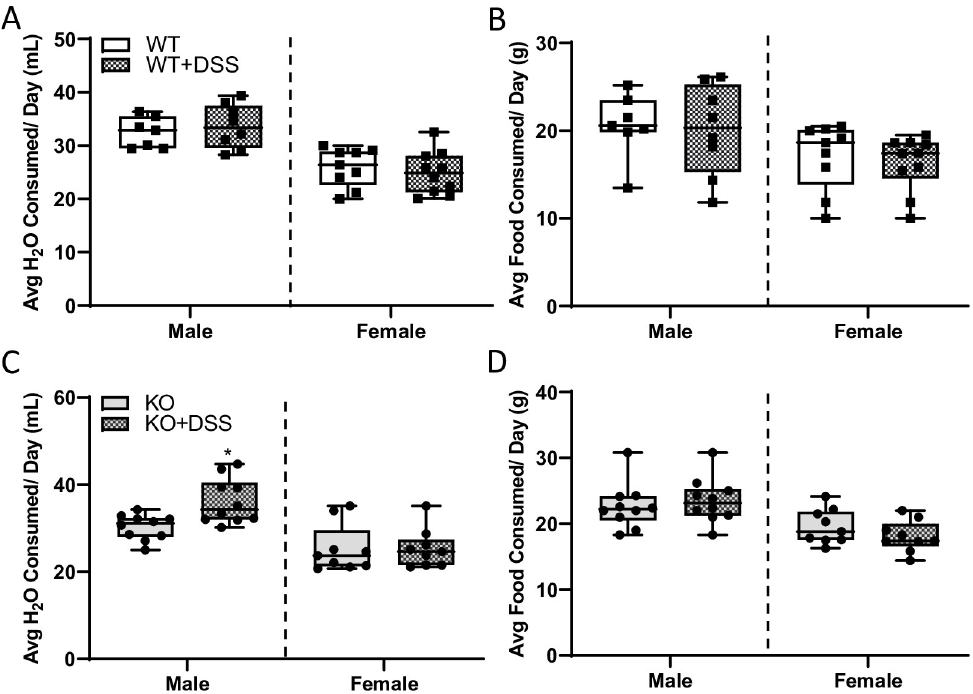
Fig 11. Food and water intake did not differ between control and DSS-treated male or female rats of the same genotype. Waterintake ( A , C )and food consumption ( B , D )were measured daily in rats of both sexes for the duration of the DSS treatment-period including at baseline Day 0 beforetreatment began. Data are presented as box plots for two independent experiments with n = 7–11 rats/group and were analyzed by 2-way ANOVA followed by Tukey’s multiple comparisons post hoc test. No significant two-way interactions were noted. Genotype p � 0.05( B,D );Treatment, p = 0.027 ( C